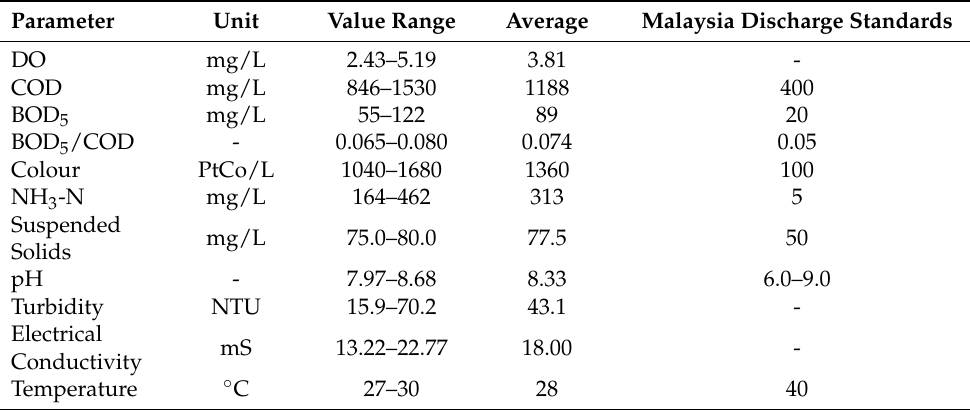
Table 1. Raw leachate